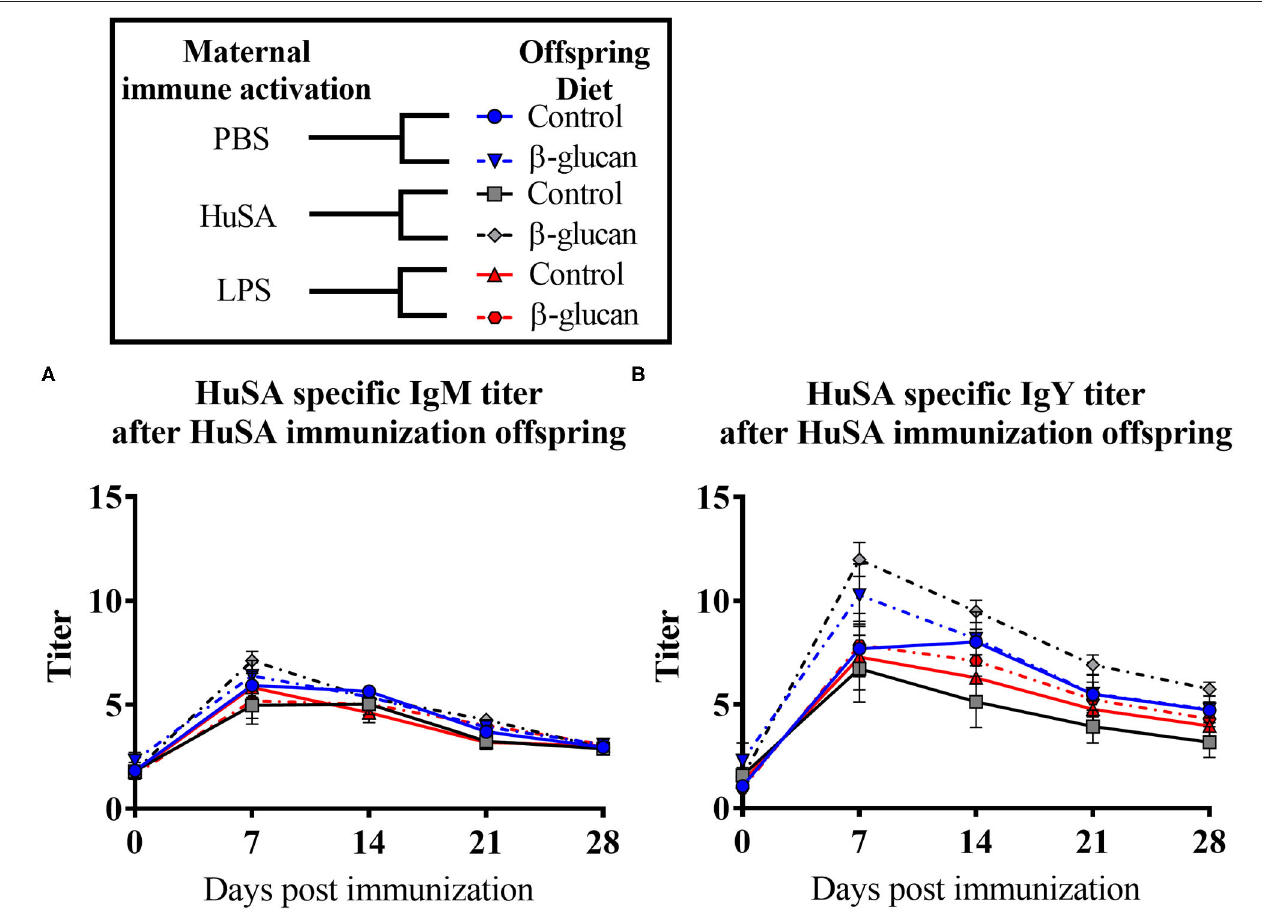
FIGURE 3 | Results of experiment 2 with IgM and IgY anti-HuSA titers of chicks originating from hens immunized with either PBS, HuSA or LPS. The chicks were fed either the control diet or the diet enriched with β -glucan. Chicks were immunized 4 weeks post hatch with HuSA and titers were measured at 0, 3, 7, 14, 21 and 28 days post immunization. (A) anti-HuSA IgM titers after HuSA immunization. (B) anti-HuSA IgY titers after HuSA immunization. Data are presented as means ± SEM, and N = 10 chickens per